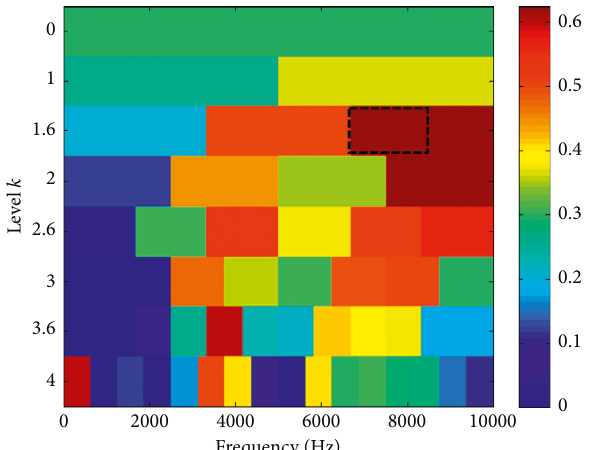
Figure 12: Fast kurtogram of signal at point